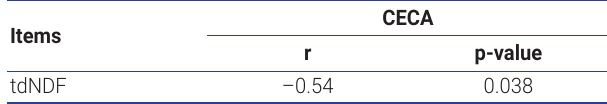
Table 7. Correlation between FTIR carbohydrate structures and the energy profile of canola seeds Items